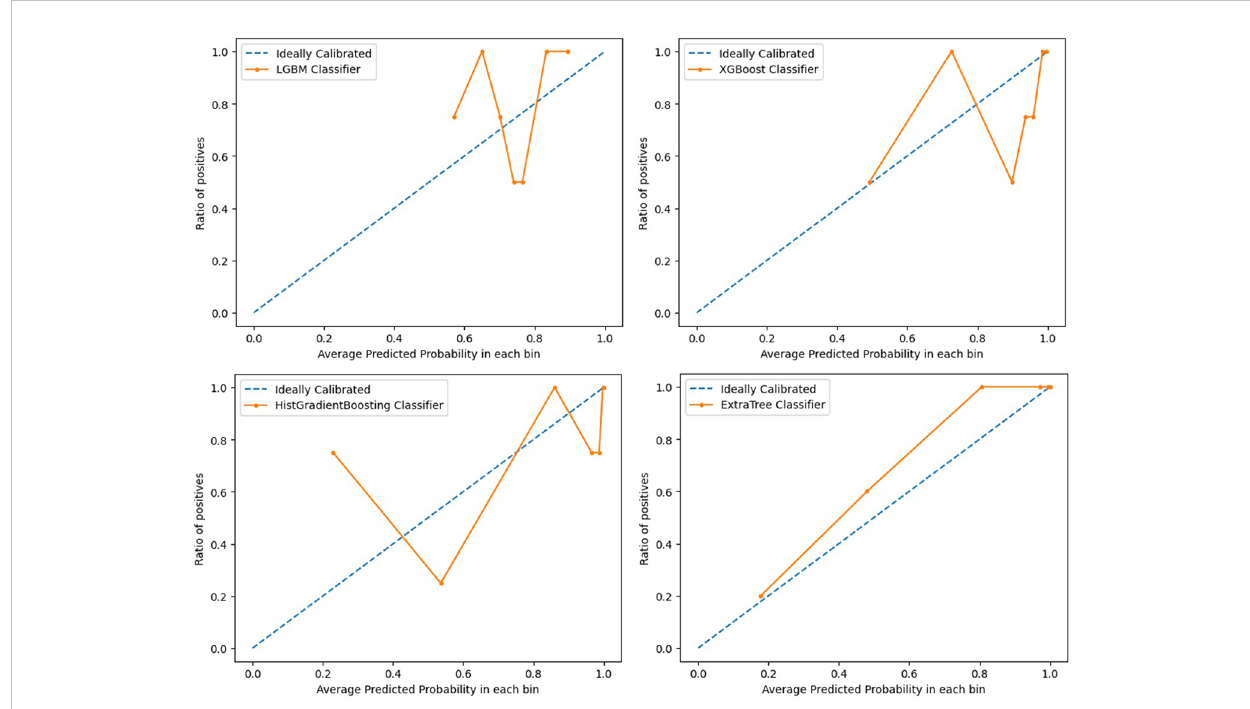
FIGURE 3 Calibration curves evaluating performance of different prediction models for progression free survival in patients with epithelial ovarian cancer (upper left: LGBM model; upper right: XGBoost model; lower left: HGBoost model; lower right: Extra-Trees model).